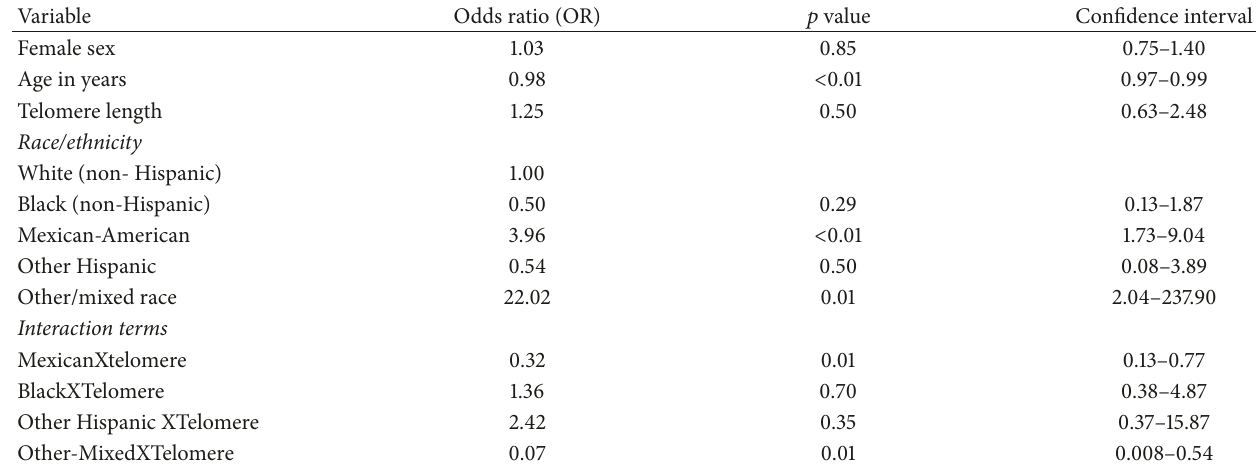
Table 1: Telomere length, race, and interaction terms on suspected nonalcoholic fatty liver disease, NHANES 1999–2002. The table included interaction terms to assess the relationship between race/ethnicity and telomere length in relation to suspected nonalcoholic fatty liver disease (defined by having elevated ALT